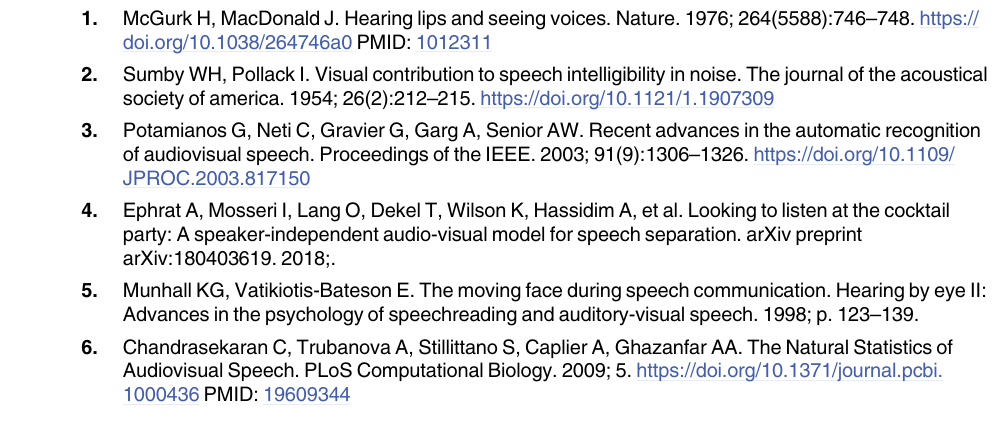
S5 Fig. Test correlations. Test correlation values for the LRS3 (left) and GRID data (right). Boxes show null distributions derived by training CCA models on mismatching AV data.